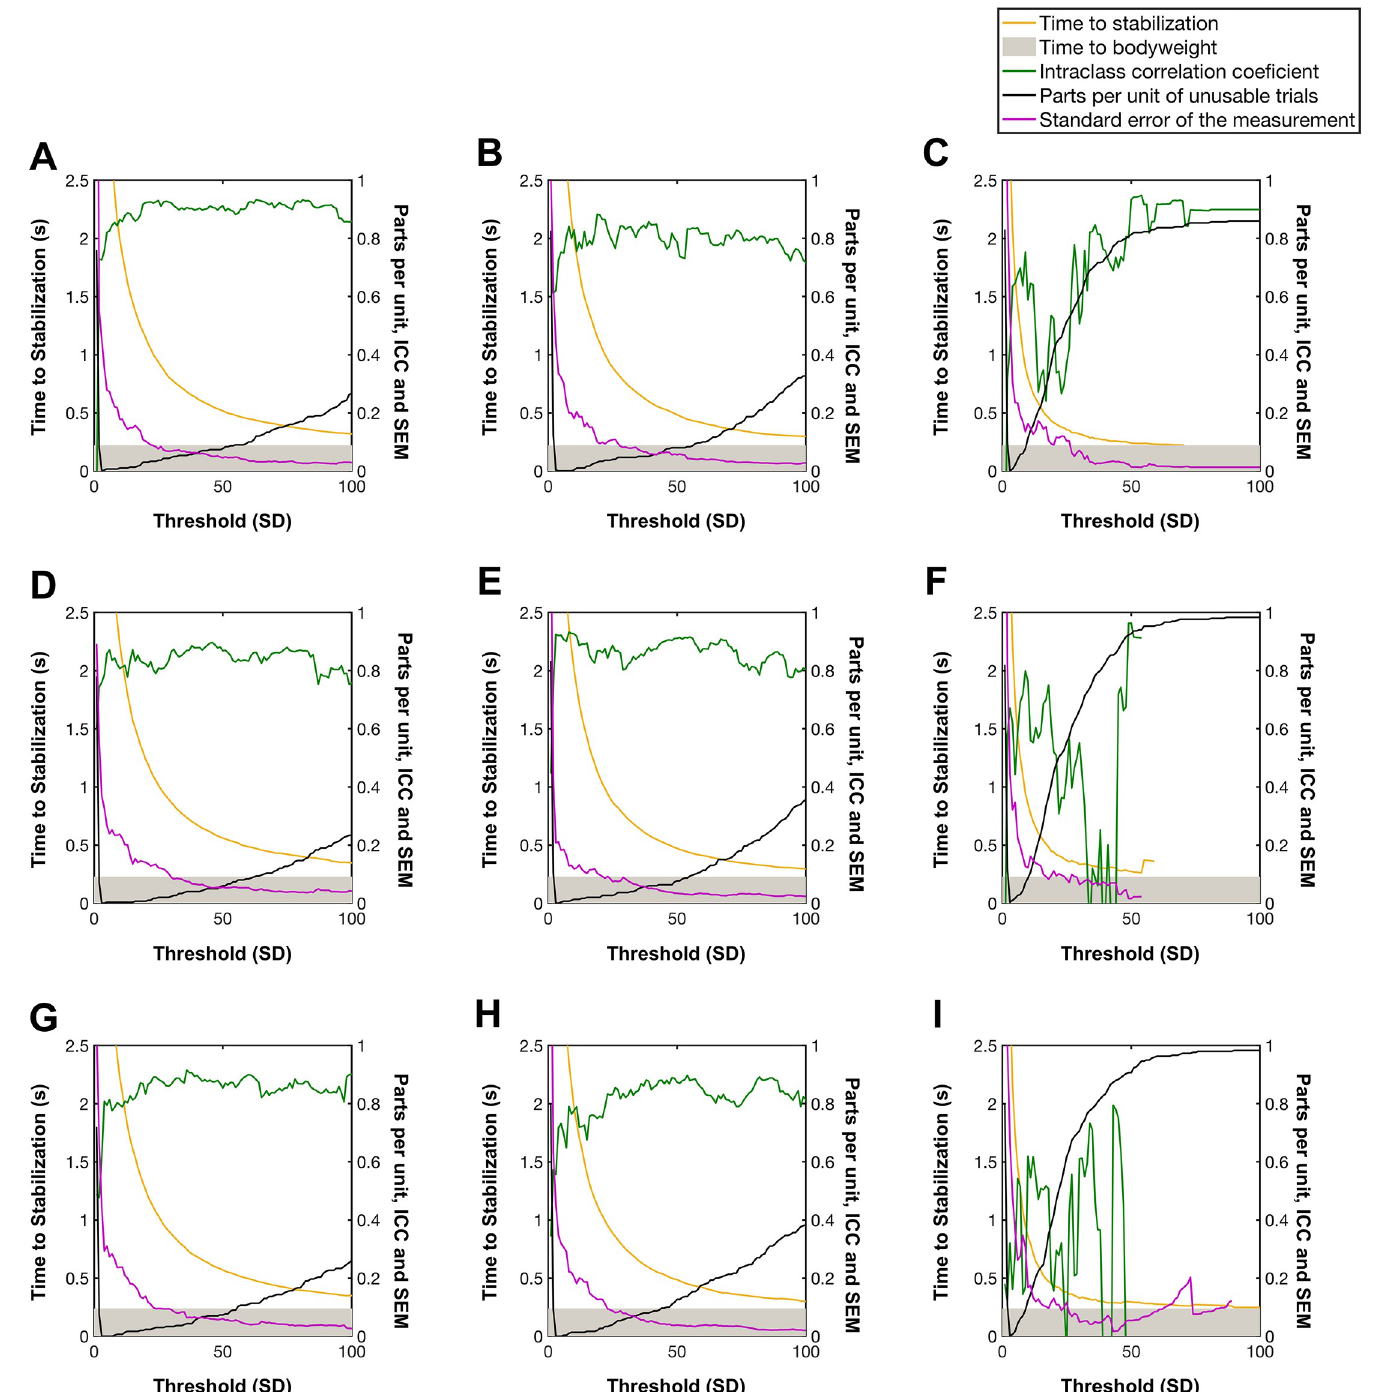
Fig 2. Reliability of the time to stabilization values in function of the threshold used. A: vertical axis and 15 cm height, B = antero-posterior axis and 15 cm height, C = medio-lateral axis and 15 cm height, D: vertical axis and 20 cm height, E = antero-posterior axis and 20 cm height, F = medio-lateral axis and 20 cm height, G: vertical axis and 25 cm height, H = antero-posterior axis and 25 cm height, I = medio-lateral axis and 25 cm height.